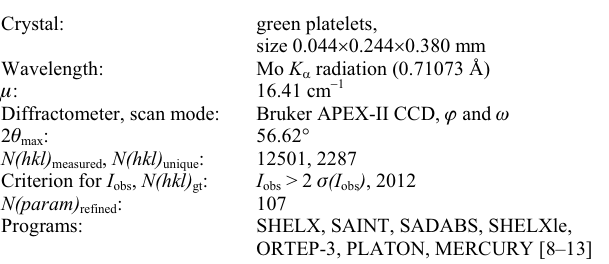
Table 1. Data collection and handling.